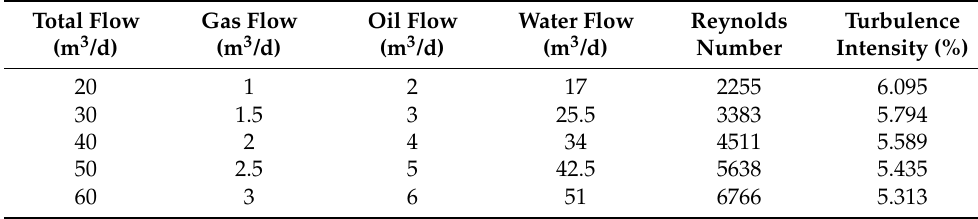
Table 4. Related parameters of oil-gas-water multiphase